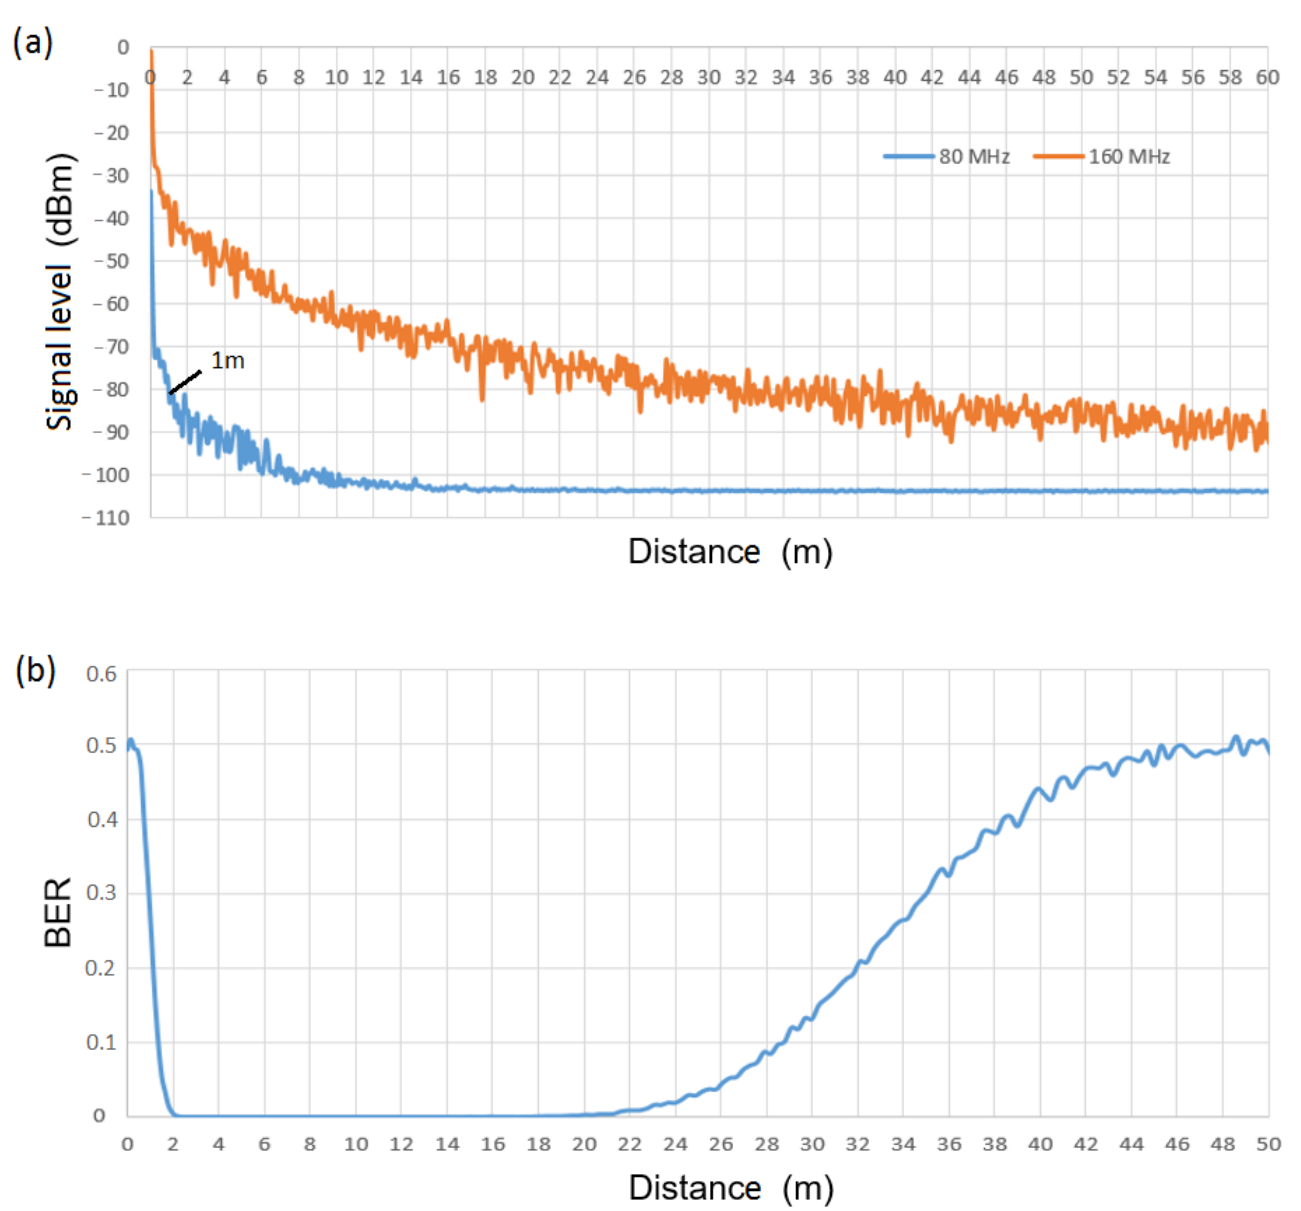
Figure 10. ( a ) Signal level at filter output of the third chain of Figure 6, ( b ) BER at the output of the third chain of the WuRx of Figure 6, vs. distance, employing 80 MHz and 160 MHz signals. Table 1. Codification